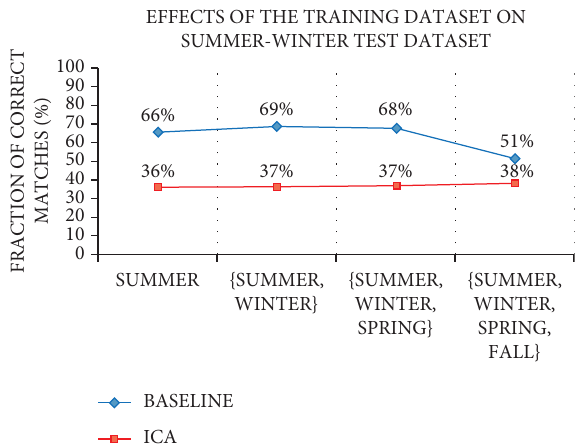
Figure 18: “SUMMER” indicates that the training images are taken from the summer season. “{SUMMER, WINTER}” suggests that the training dataset contains images from the summer and winter seasons. Similar interpretations apply for the other two training datasets.